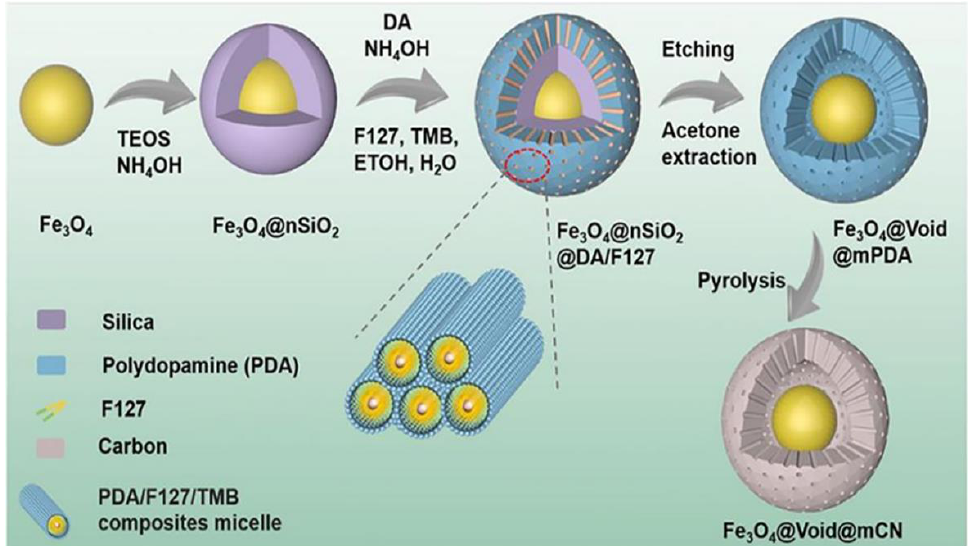
Figure 4. Preparation of Fe 3 O 4 , mPDA and derivative Fe 3 O 4 @mCN microspheres. Reproduced with permission from ref. [18]. Copyright © 2022, American Chemical Society.